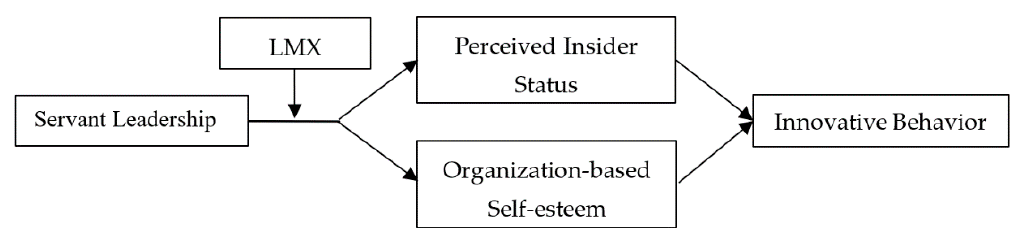
Figure 1. Hypothesized model.